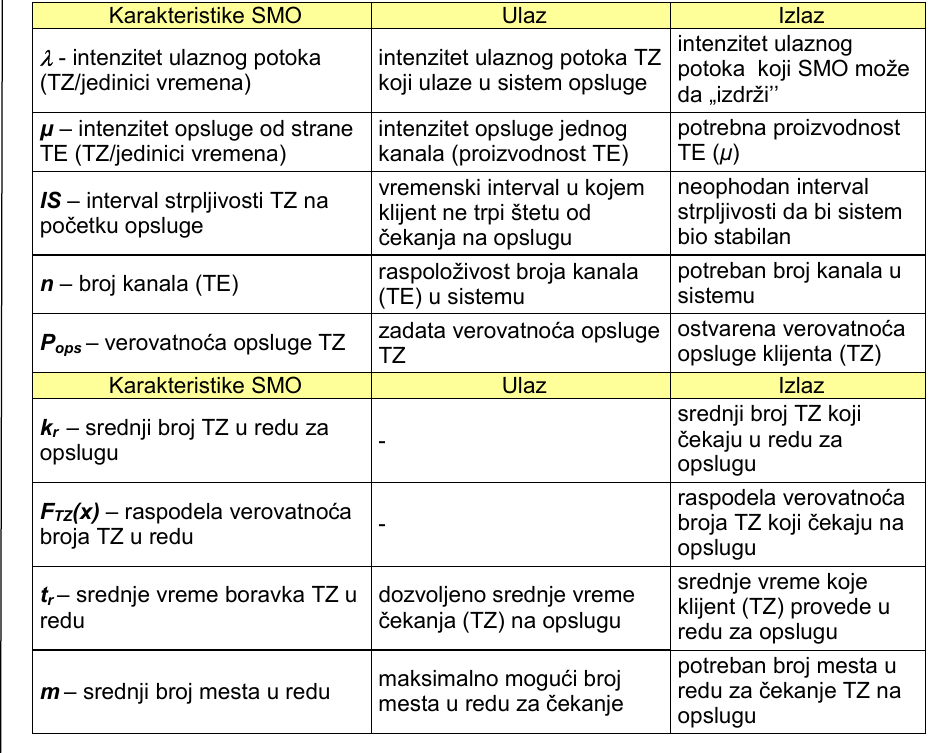
Pregled osnovnih karakteristika SMO Review of the MSS key